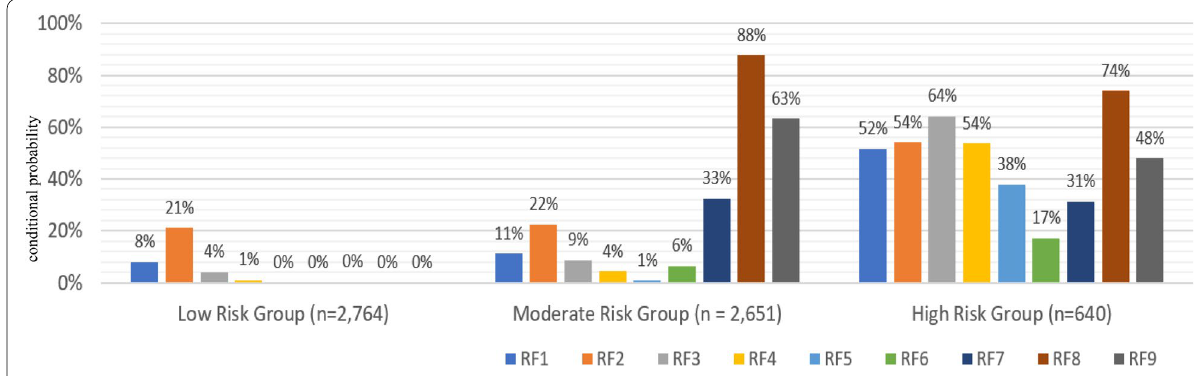
Fig. 2 Conditional Probabilities of Having One Health Related Risk Factors (RF) by Group. Note: RF1 with rodents; RF3 Loss of crops due to environment problems; RF4 = slaughter at home; RF7 Household insects (others); RF8 = vaccinations, poor